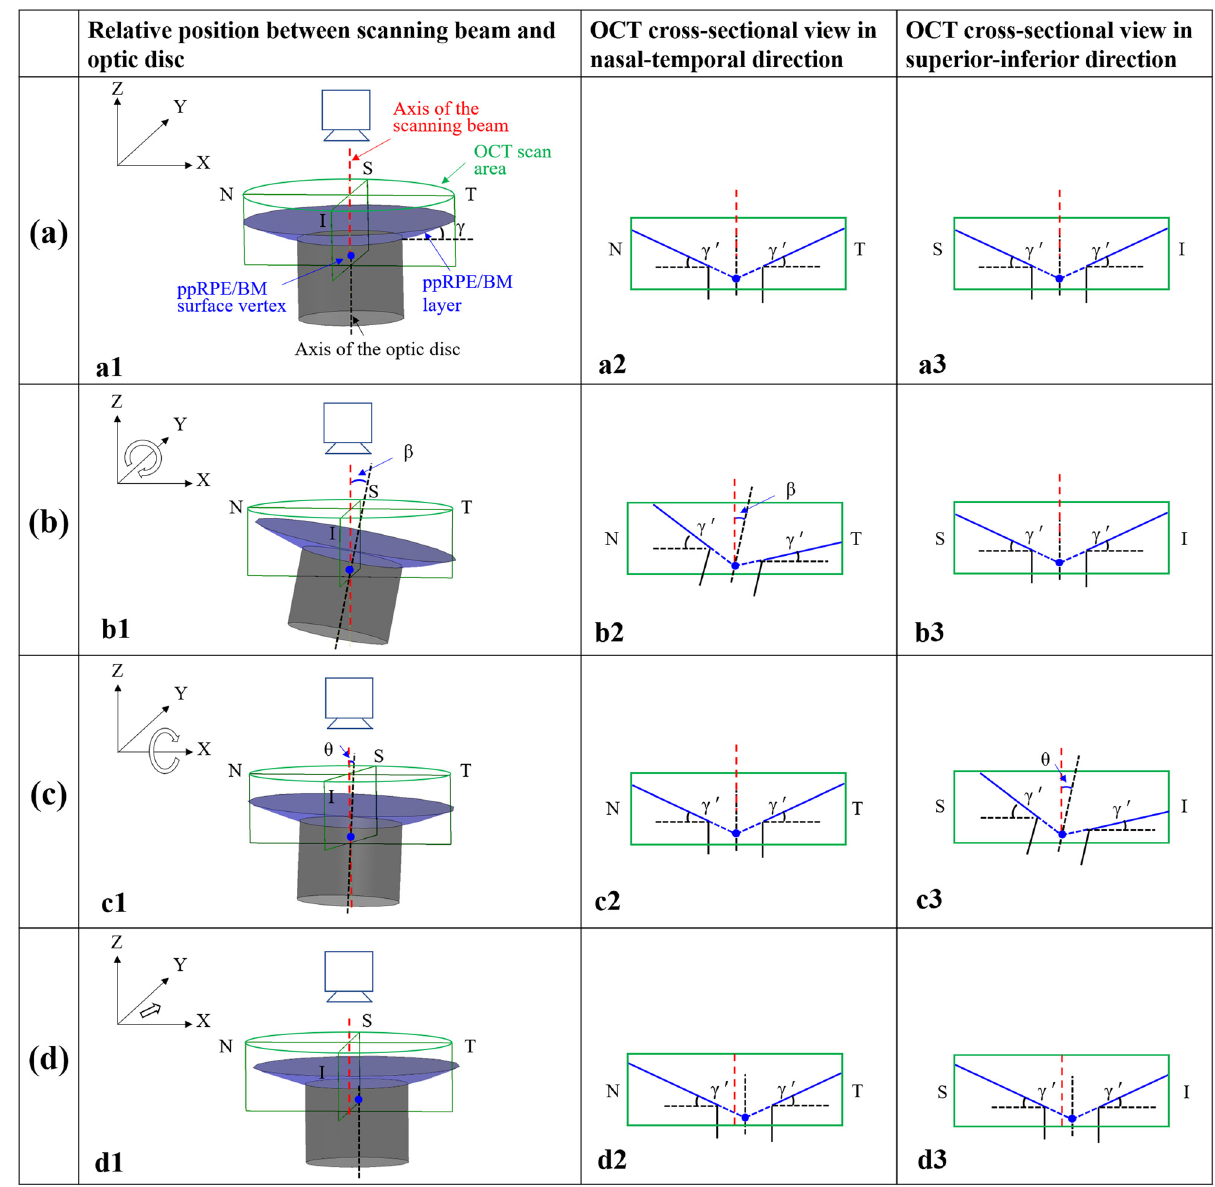
Figure 2: Schematic diagrams of the ppRPE/BM layer morphology with columns: relative position between the OCT scanning beam and optic disc; the OCT cross - sectional view in nasal - temporal direction; and the OCT cross - sectional view in the superior - inferior direction. The ppRPE/BM layer angle ( γ ′ ) refers to the angle between the ppRPE/BM layer and the horizontal plane of a 2D scan. ( Row a ) the axis of OCT scanning beam coincides with the axis of the optic disc; ( Row b ) case with a tilt angle ( β ) between the axis of OCT scanning beam and the axis of the optic disc in the nasal - temporal direction; ( Row c ) : case with a tilt angle ( θ ) between the axis of OCT scanning beam and the axis of the optic disc in the superior - inferior direction; ( Row d ) the axis of OCT scanning beam is parallel with the axis of the optic disc, with the ppRPE/BM surface vertex o ff the axis of the scanning beam. S, I, N, and T indicate superior, inferior, nasal, and temporal, respectively. The green box marks the OCT scanning area; the blue surface represents the ppRPE/BM layer; the gray surface represents the optic nerve surface. The red dash line represents the axis of the scanning beam, and the black dash line represents the axis of the optic disc. The blue line represents the ppRPE/BM layer in the 2D view, with the blue dashed line as the extended ppRPE/BM layer. The blue dot represents the conical vertex of the ppRPE/BM